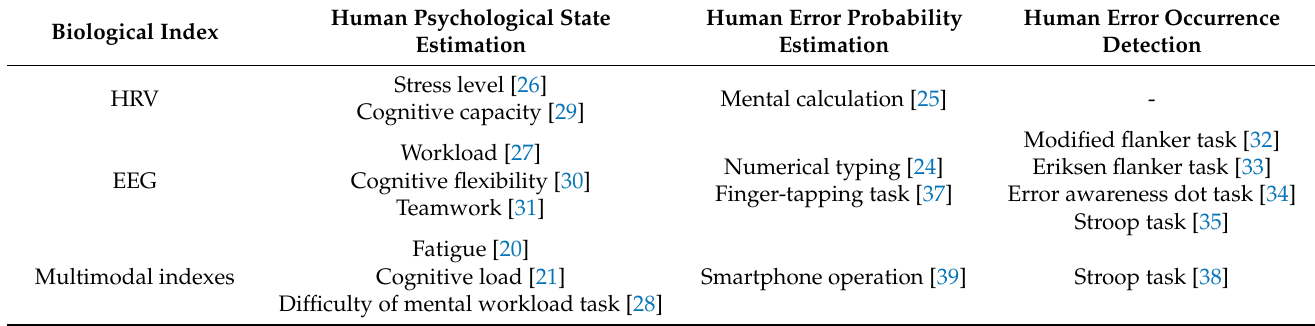
Table 1. Previous studies using biological information and the targeted estimation of human